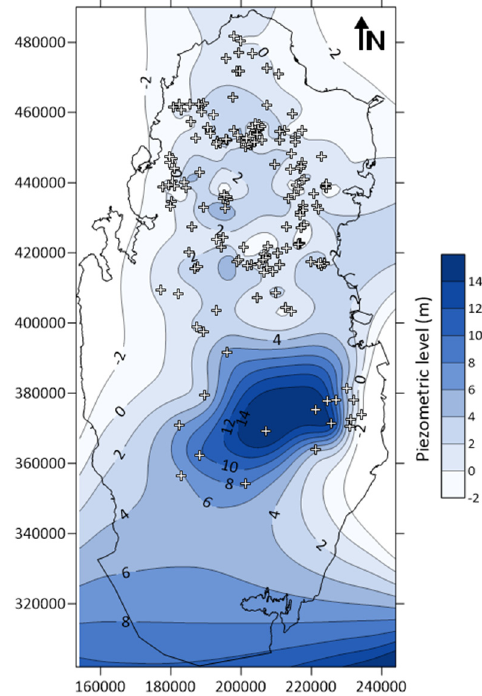
Figure 3. Minimum curvature interpolation piezometric map and location of the wells (white cross) monitored for heads during the 2017 campaign.